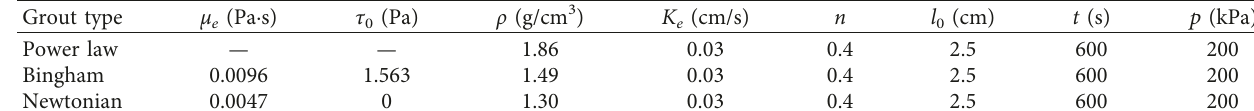
Table 1: Parameters of three grouts used for the study.